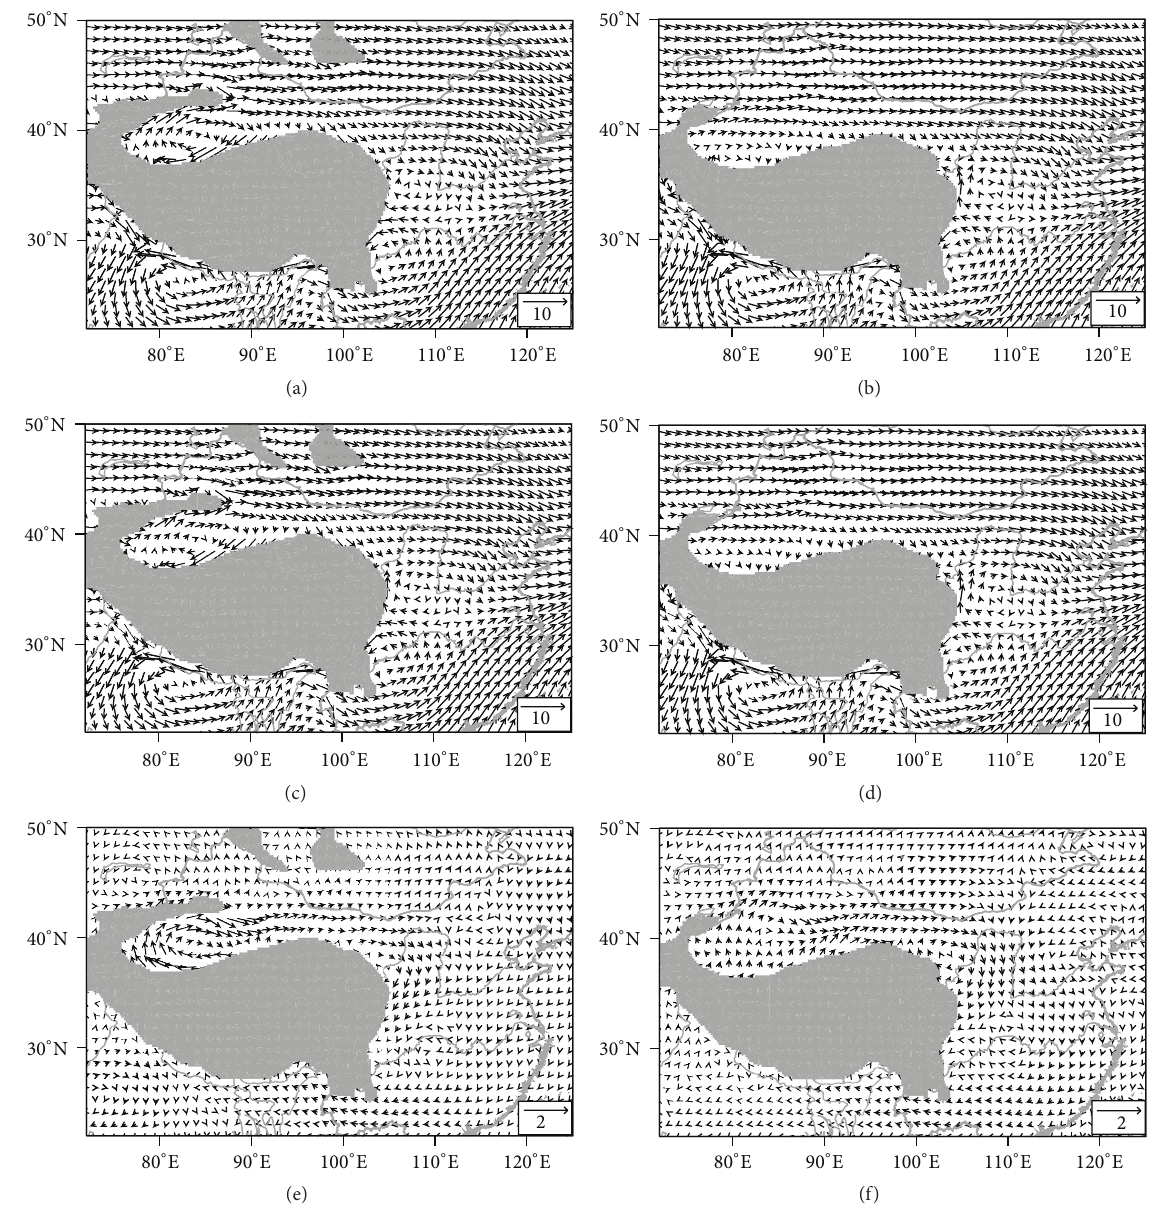
Figure11:700hPawindfieldaveragedinsummer(JunetoAugust)in(a)HMD,(b)HM,(c)LMD,(d)LM,(e)HMD − HM,and(f)LMD − LM. The grey area represents the topography below 700